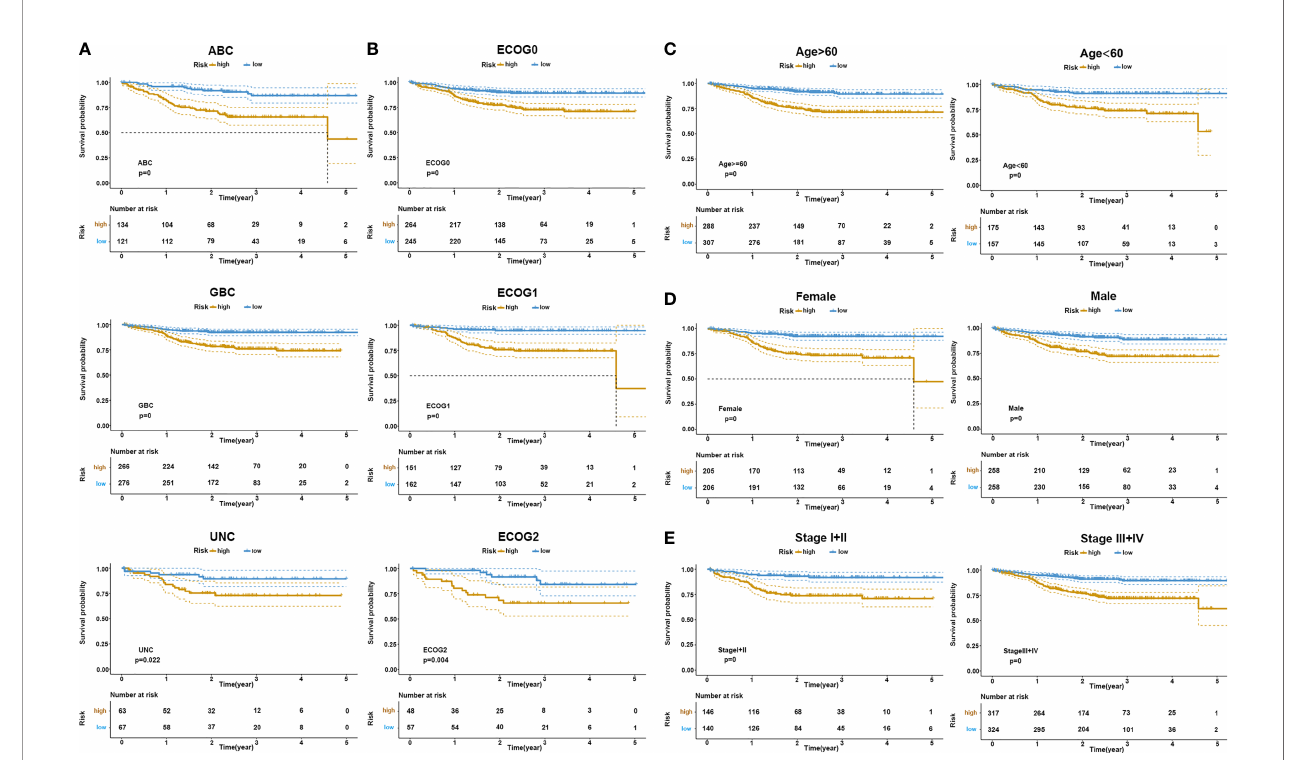
FIGURE 4 | KM survival strati fi cation analyses in the GSE117556 dataset. (A) COO subgroup. (B) ECOG stage. (C) Age. (D) Gender. (E) Clinical